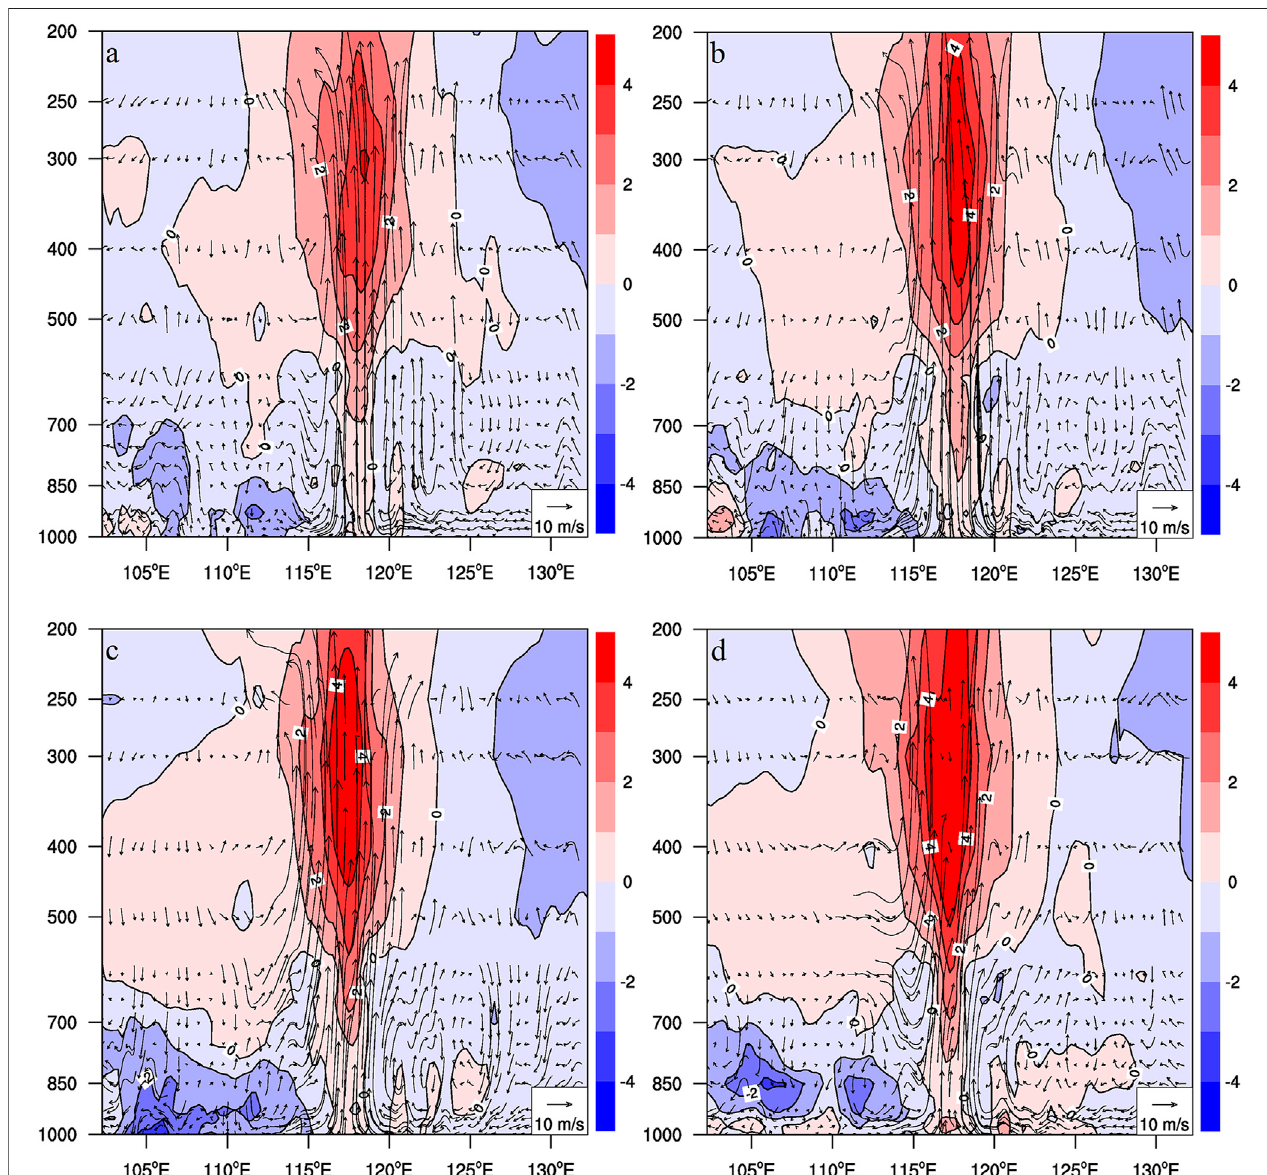
FIGURE 5 | The vertical pro fi le of the temperature abnomaly (Contours with shaded) and vertical wind vectors (made by u and w*10) at different stages. (A) T-12, (B) T-6, (C) T, (D) T+6.